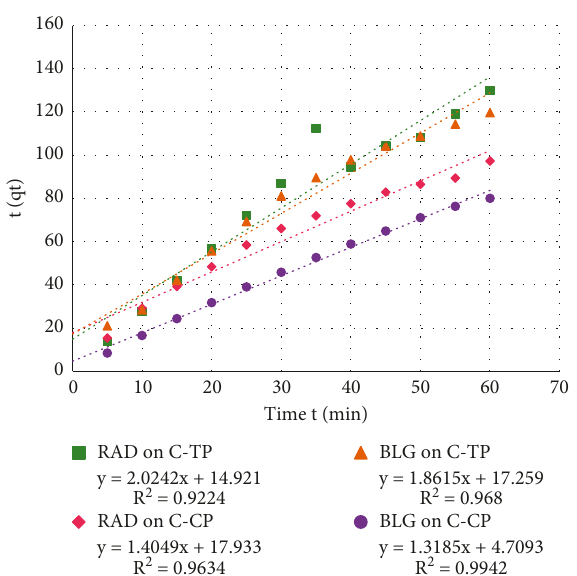
Figure 18: A comparison of the pseudo-second-order kinetics for the adsorptive dye removal performance of acid-treated bio- sorbents. Initial pH � 5, final pH for RAD on C-TP and C-CP �